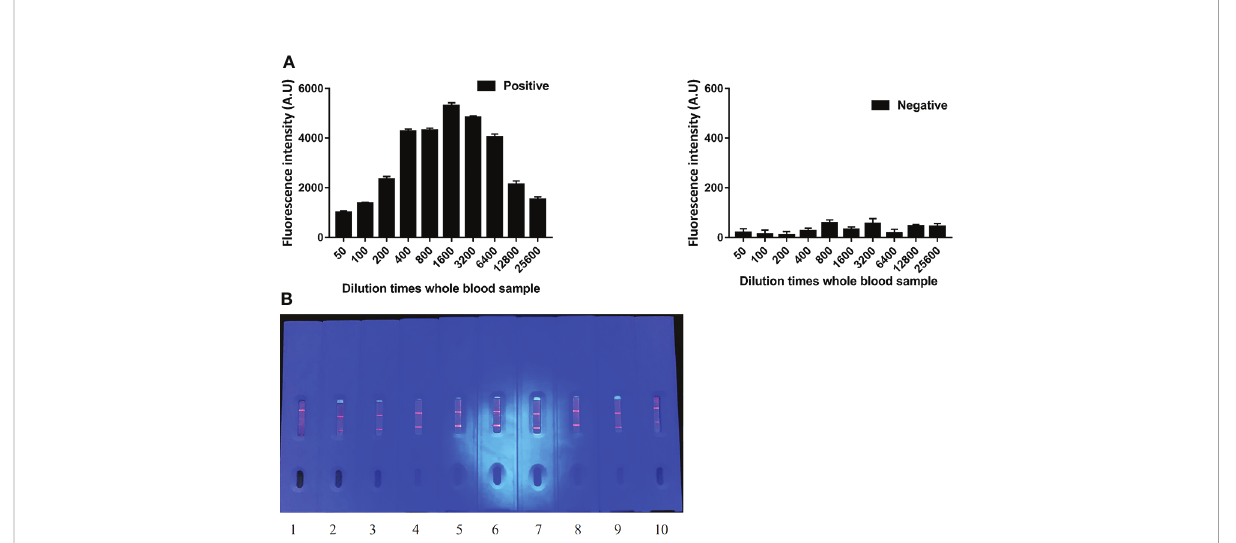
FIGURE 3 The dilution limit of whole blood samples by ECM-ICS. (A) ECM-ICS was analyzed by the TRF reader. (B) Visual results of ICS under ultraviolet light. 1, 2, 3, 4, 5, 6, 7, 8, 9, and 10 represent the whole blood samples diluted 50, 100, 200, 400, 800, 1,600, 3,200, 6,400, 12,800, and 25,600